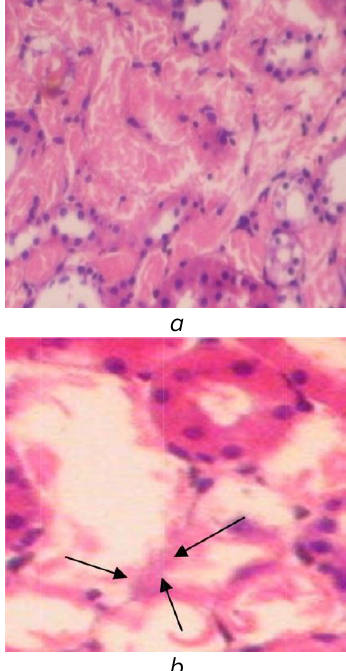
Fig. 2. Rat kidney with a model of glycerol acute renal failure for 3 days after the administration of glycerol: a – necrosis of the distal and proximal parts of the tubules of the nephrons, vacuolal dystrophy of the nephrocytes of isolated preserved tubules; b – destruction of basement membranes (arrows) of necrotic tubules. Hematoxylin-eosin. × 200, ×